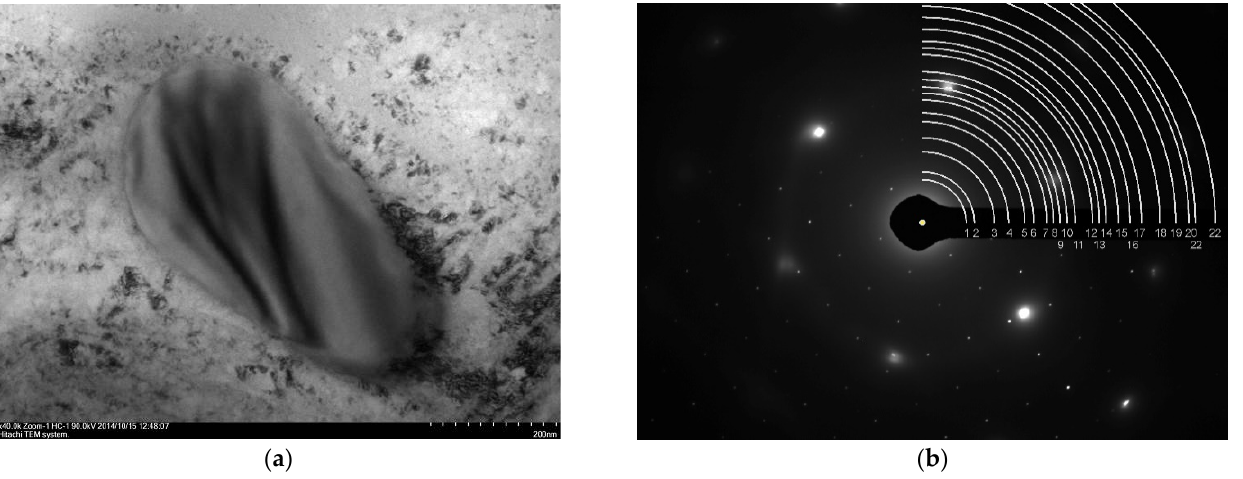
Figure 6. Electron microscopic image from the neck region of the stretched Ni 51 Ti 49 sample ( a ) and electron diffraction from this region ( b ).